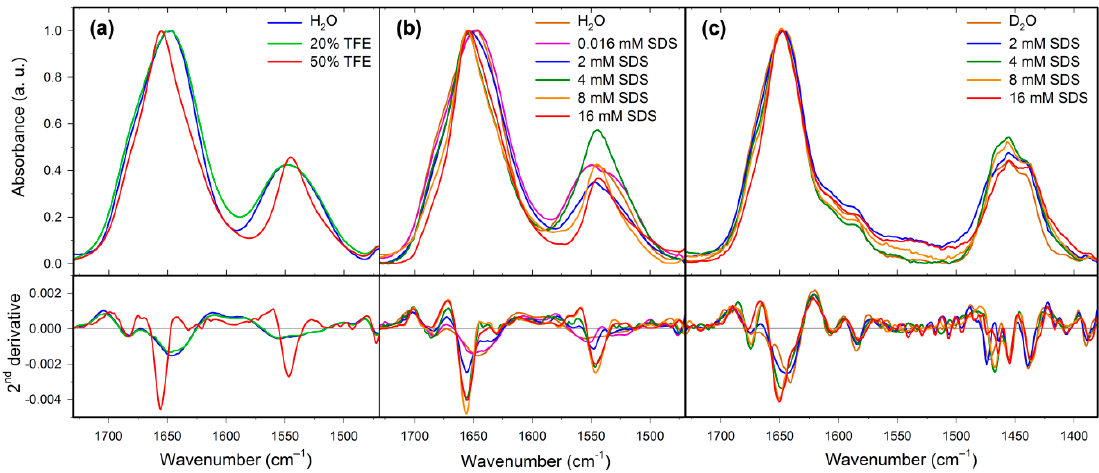
Figure 6. IR spectra ( top ) and their second derivatives ( bottom ) of HAL-1 (10 mg/mL) in ( a ) the presence of TFE (0%, 20%, and 50%); ( b ) of SDS/H 2 O solution (0.016, 2, 4, 8, and 16 mM SDS). ( c ) of SDS/D 2 O solution (2, 4, 8, and 16 mM SDS).